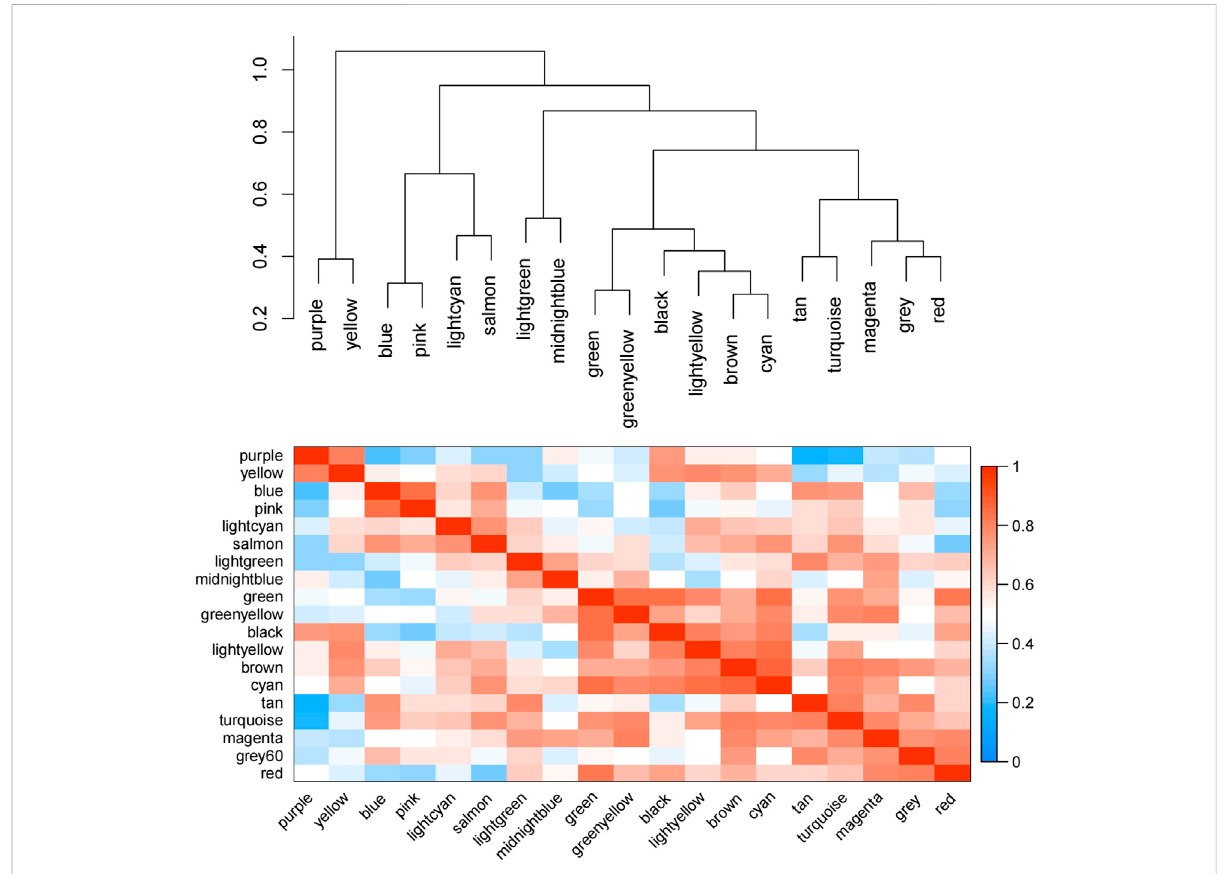
FIGURE 7 Correlation between 19 modules. The depth of red represents the strength of the